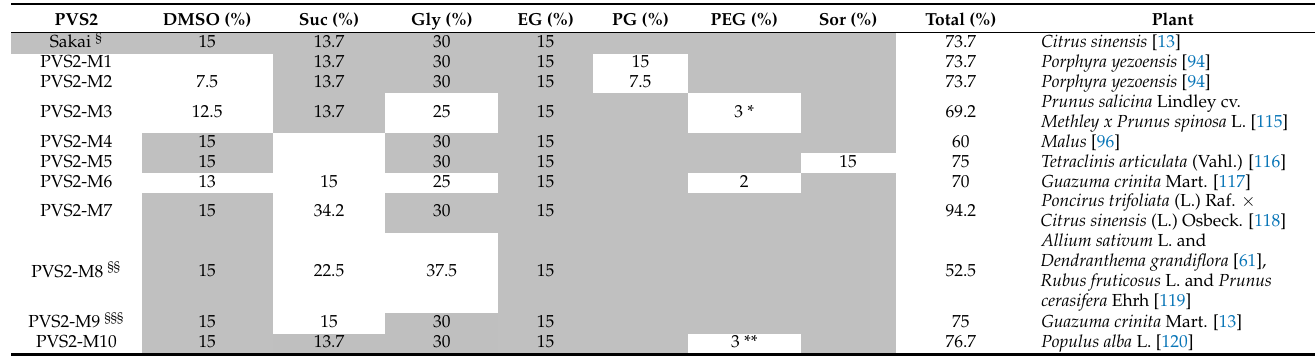
Table 3. Composition and modification in concentration of substances of Plant Vitrification Solution 2 (PVS2) Sakai [13].